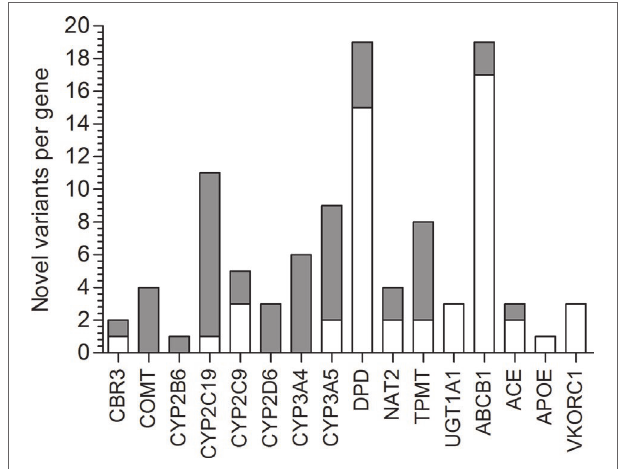
FIGURE 1 | Novel variation and its functional impact identified in 16 PGKB genes in Natives (gray) and Mestizos (blank).